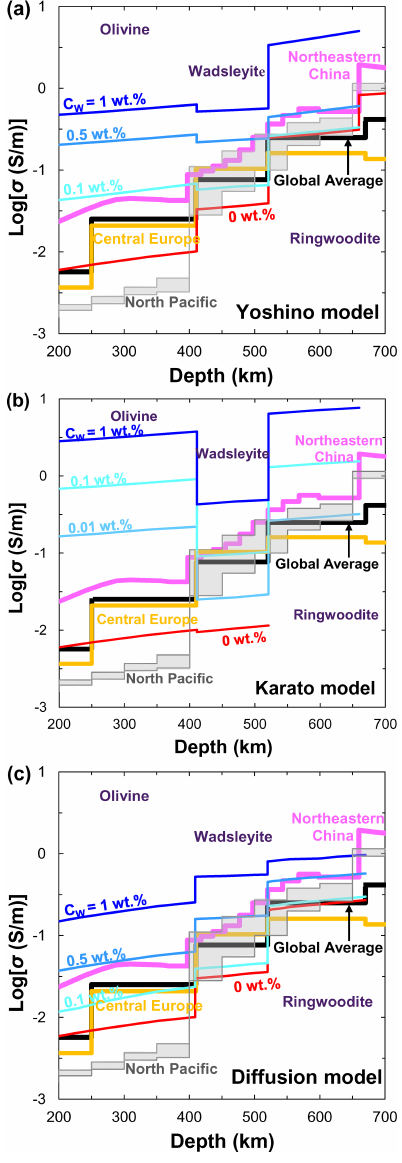
Figure 17. Comparison of laboratory-based conductivity–depth profiles of the mantle with olivine composition as a function of wa- ter content (wt.%) for the adiabatic mantle geotherm (Katsura et al., 2010) with the geophysically observed electrical conductivity in the mantle. (a) Profiles constructed from data by Yoshino and cowork- ers (olivine: Yoshino et al., 2009; wadsleyite: Yoshino and Katsura, 2012; ringwoodite: Yoshino et al., 2008). (b) Profiles constructed from data by Karato and coworkers (olivine: D. Wang et al., 2006; wadsleyite: Dai and Karato, 2009; ringwoodite: Huang et al., 2005). (c) Profiles constructed from H self-diffusion data (olivine: Sun et al., 20019; wadsleyite: Sun et al., 2018; ringwoodite: Sun et al., 2015). For dry olivine, data from Xu et al. (2000) are used. Global average (Kelbert et al., 2009); central Europe (Tarits et al., 2004); North Pacific (Utada et al., 2003; Shimizu et al., 2010); northeastern China (Ichiki et al.,